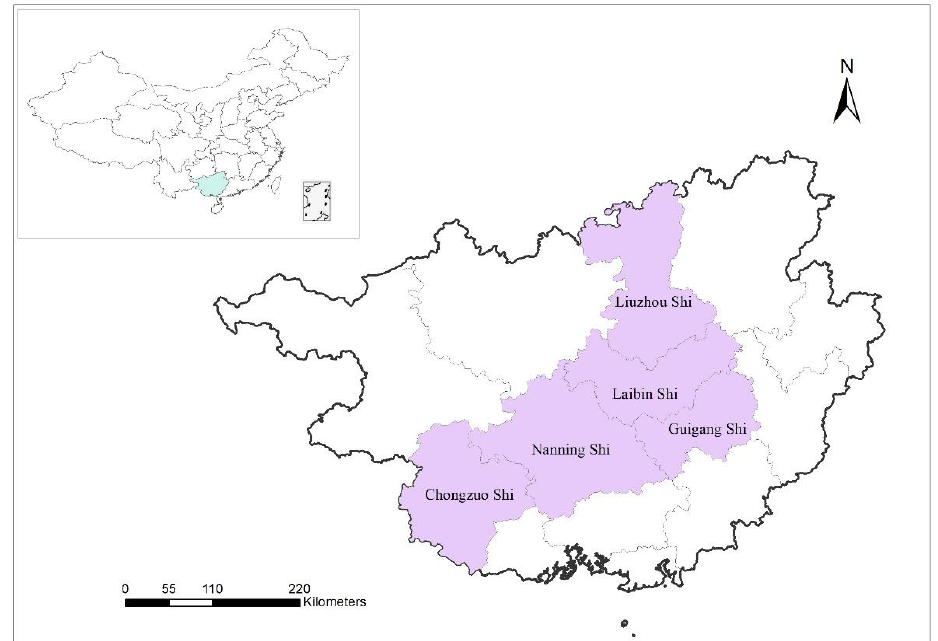
Figure 1. Geographical location of the five cities in Guangxi